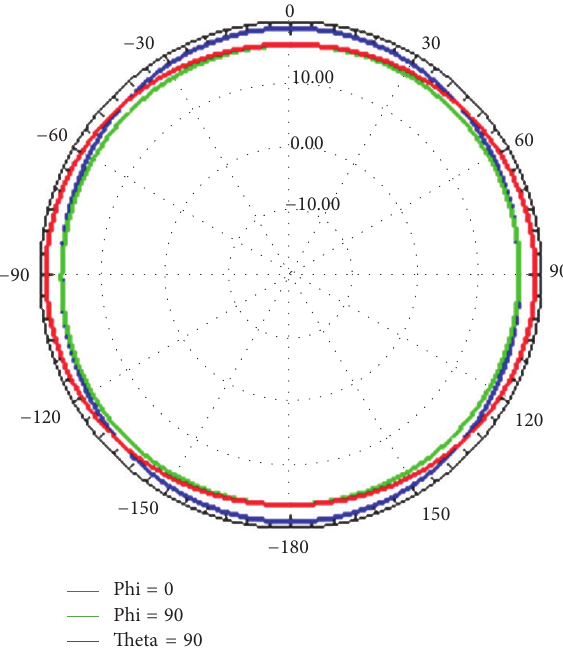
Figure 30: Radiation patterns ( 𝐸 total ) in 2D of 3D spherical antenna (Table 11) in the plans: 𝑥𝑧 , 𝑦𝑧 , and 𝑥𝑦